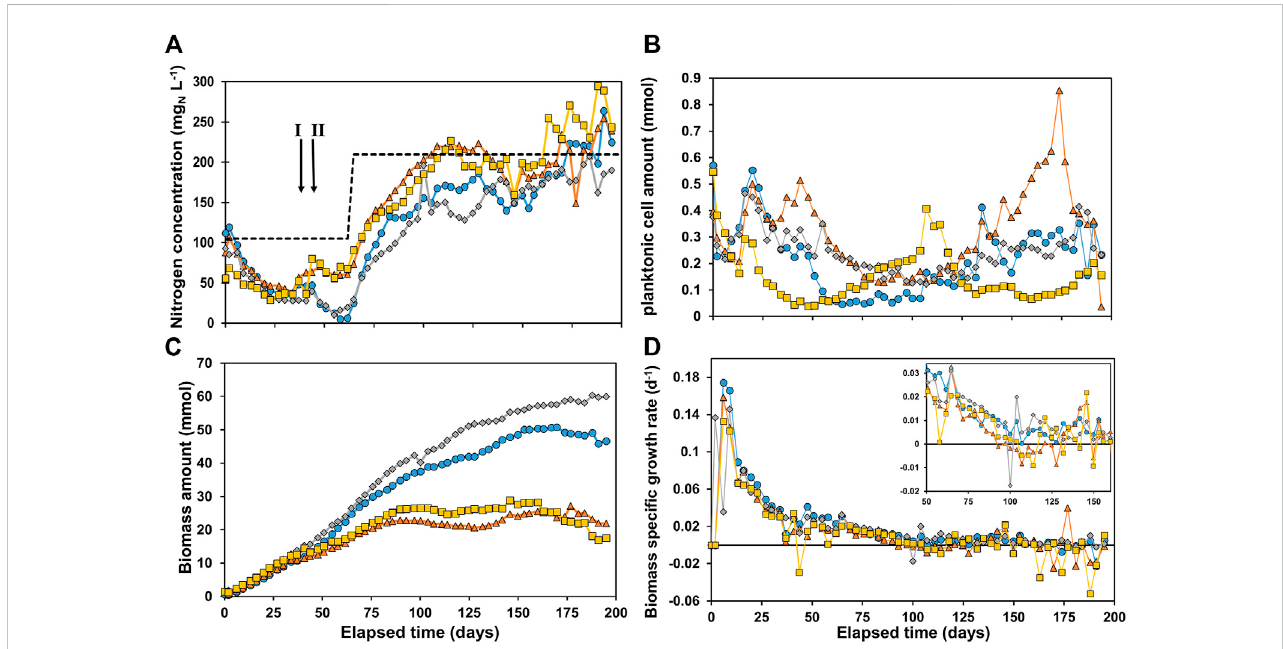
FIGURE 1 (A) Nitrogen concentration in the reactors, with the total nitrogen in fl ow concentration as dashed line (B) planktonic cell amount in the reactor, (C) total biomass amount in the reactor and (D) speci fi c growth rate μ . R1 is in blue circles, R2 in orange triangles, R3 in grey diamonds, and R4 in yellow squares. The arrows in Figure 1A indicate event I and II as discussed in the materials and methods